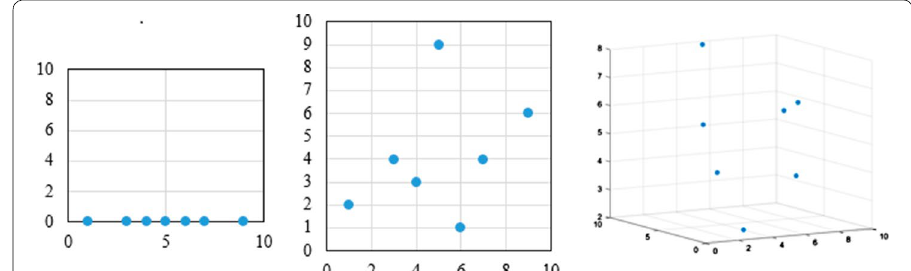
Fig. 3 The effect of the curse of dimensionality when projected in (1) one dimension, (2) two dimensions, and (3) three